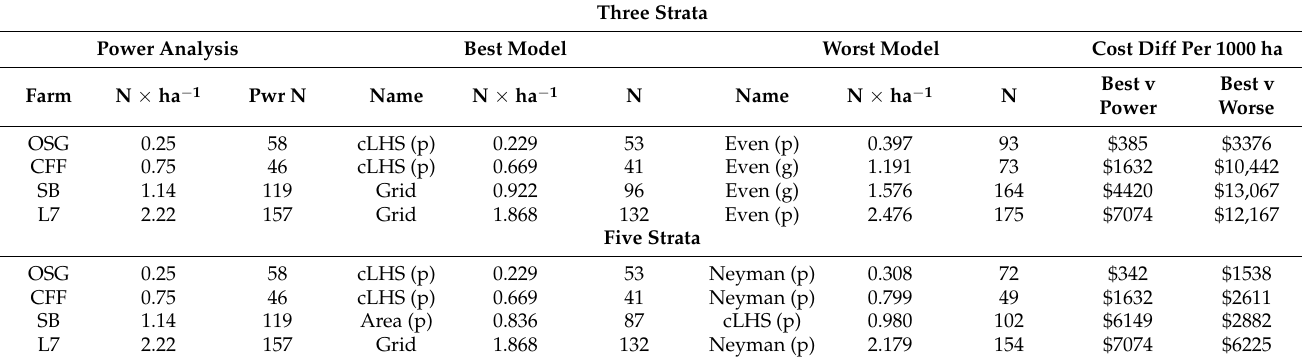
Table 3. Cost difference for best vs. worst samples (N) scaled up to 1000 ha per site. Parentheses after model names reflect inputs to stratification: geospatial (g) or polaris (p). Three